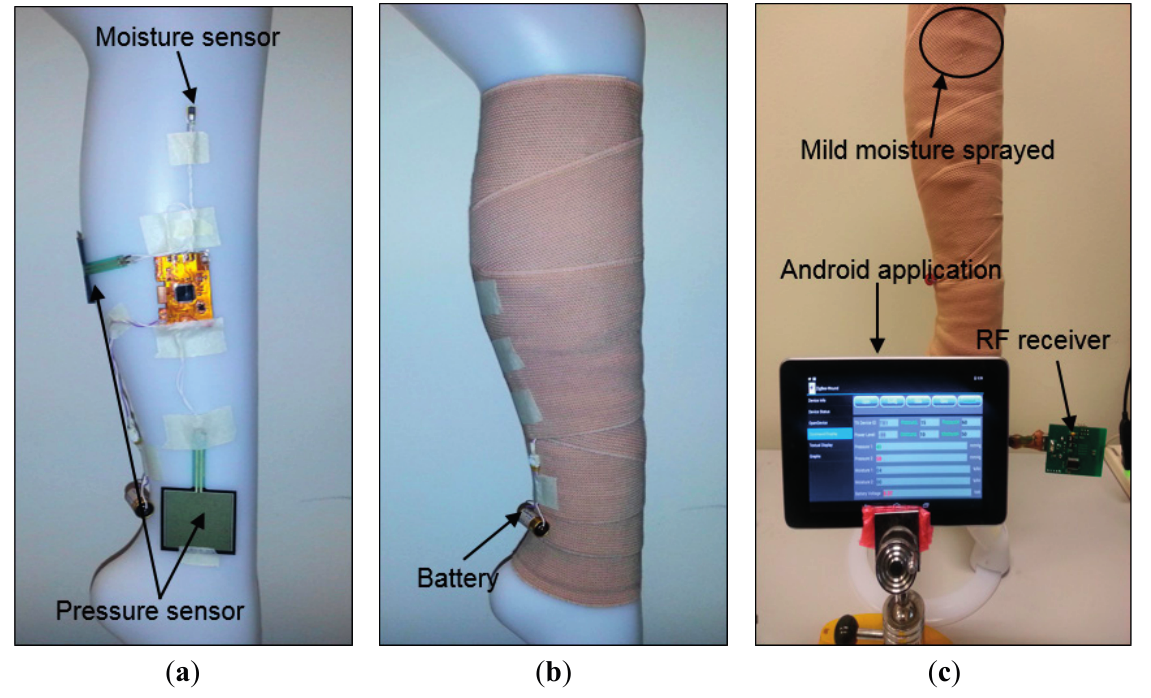
Figure 8. ( a ) Placement of the sensing system, pressure, and moisture sensors prior to application of bandage; ( b ) flexible pressure bandage wrapped over the sensing system; ( c ) measurements using the receiver attached to the mobile device running the developed App for data acquisition, processing, and